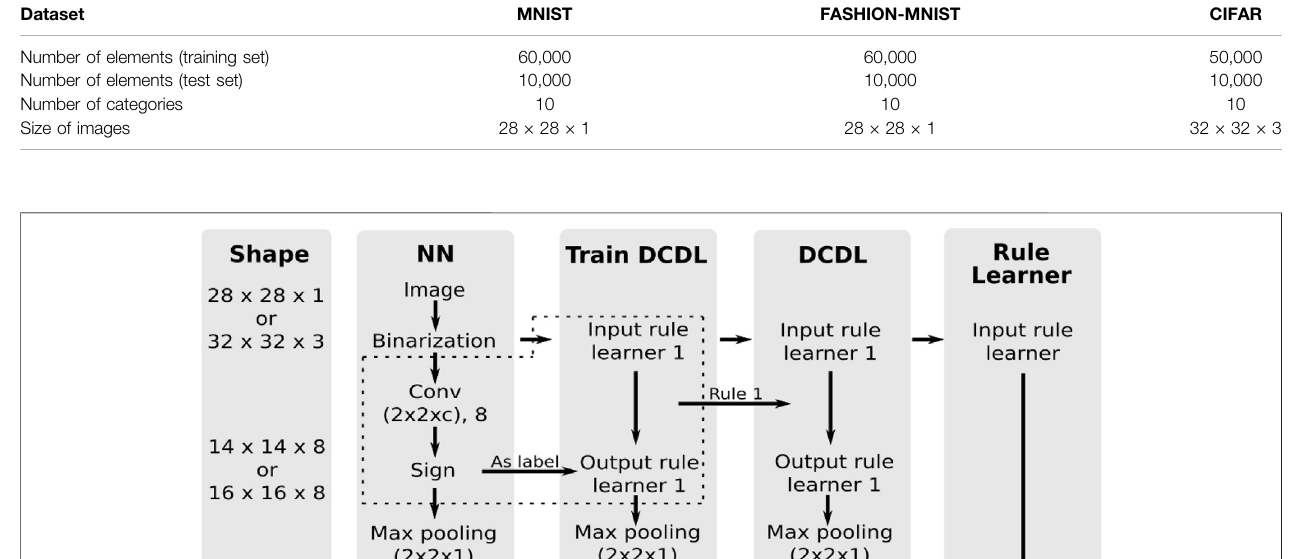
Frontiers in Arti fi cial Intelligence |